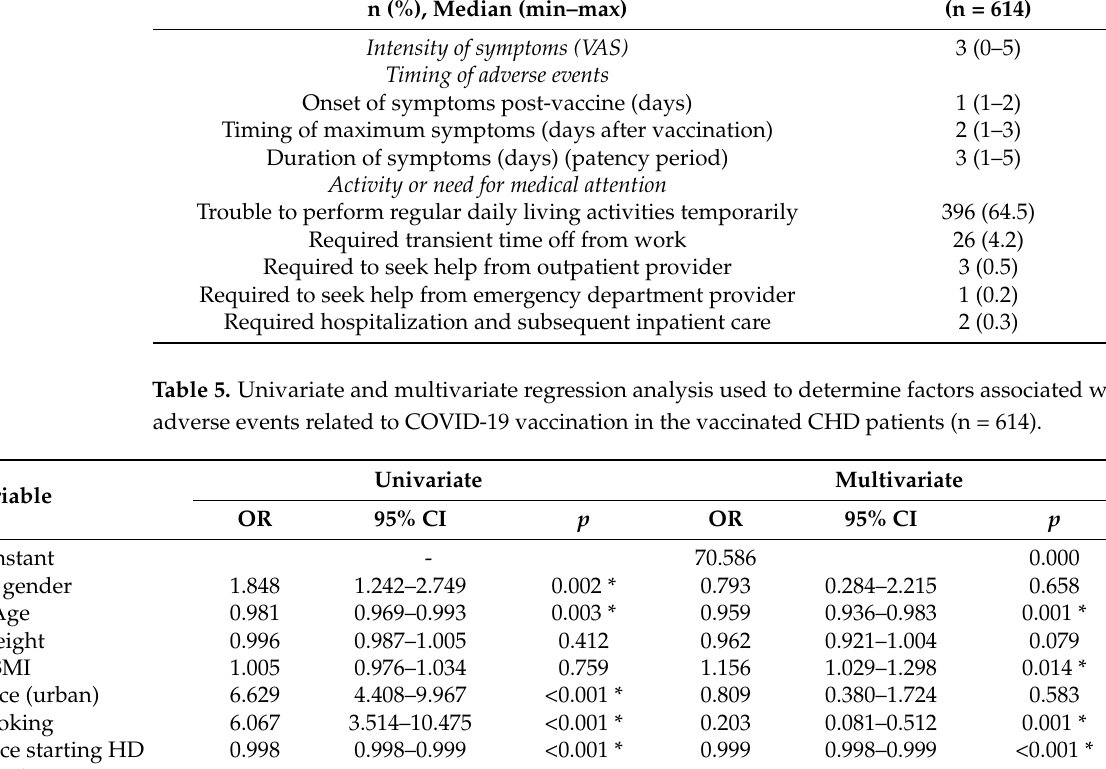
Table 4. Data about the adverse events of COVID-19 vaccine in the vaccinated CHD patients (n = 614). Variable